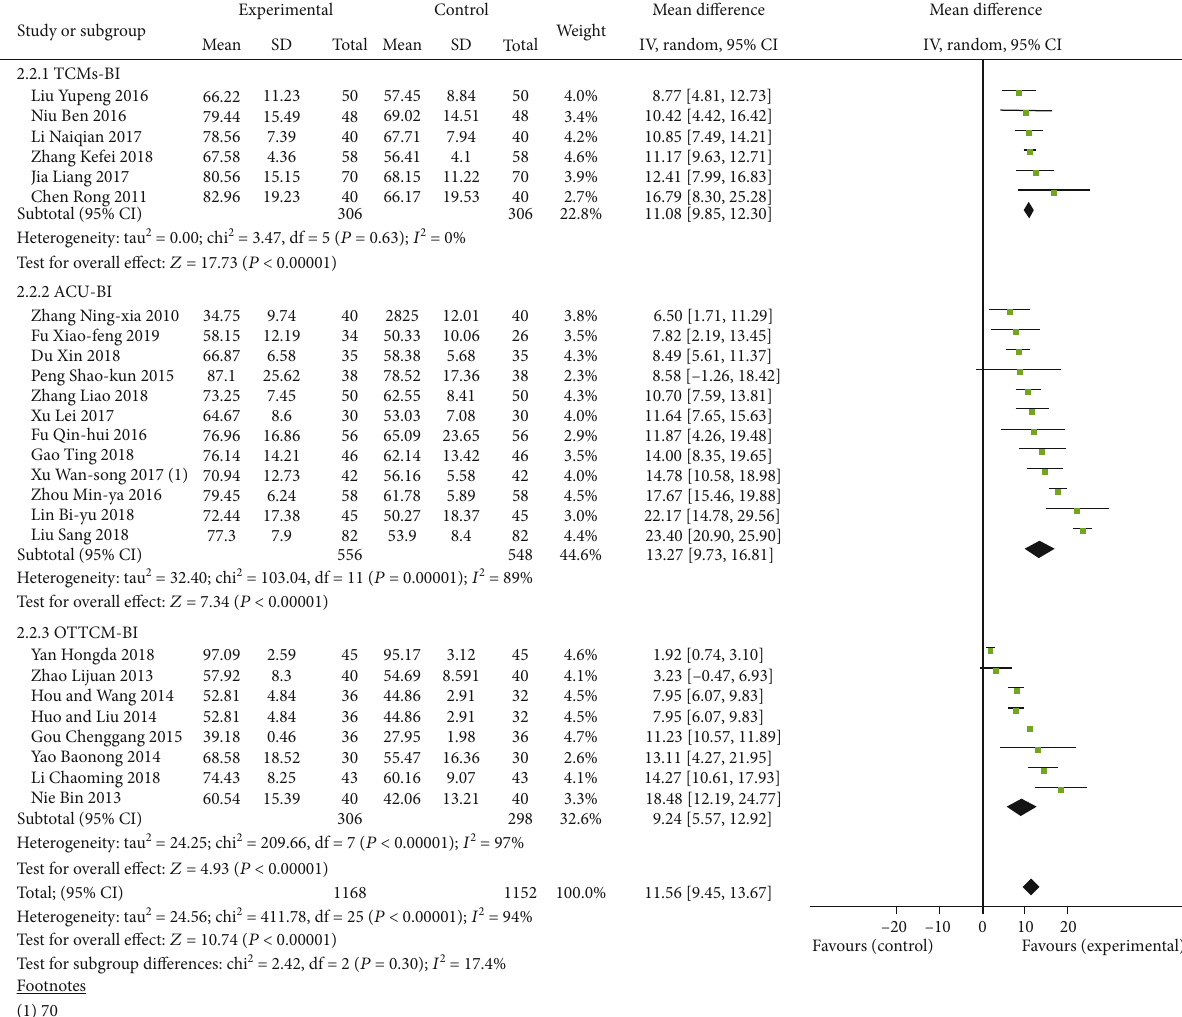
Figure 8: Forest plot of the BI treated with TCMs, ACU, and OTTCM